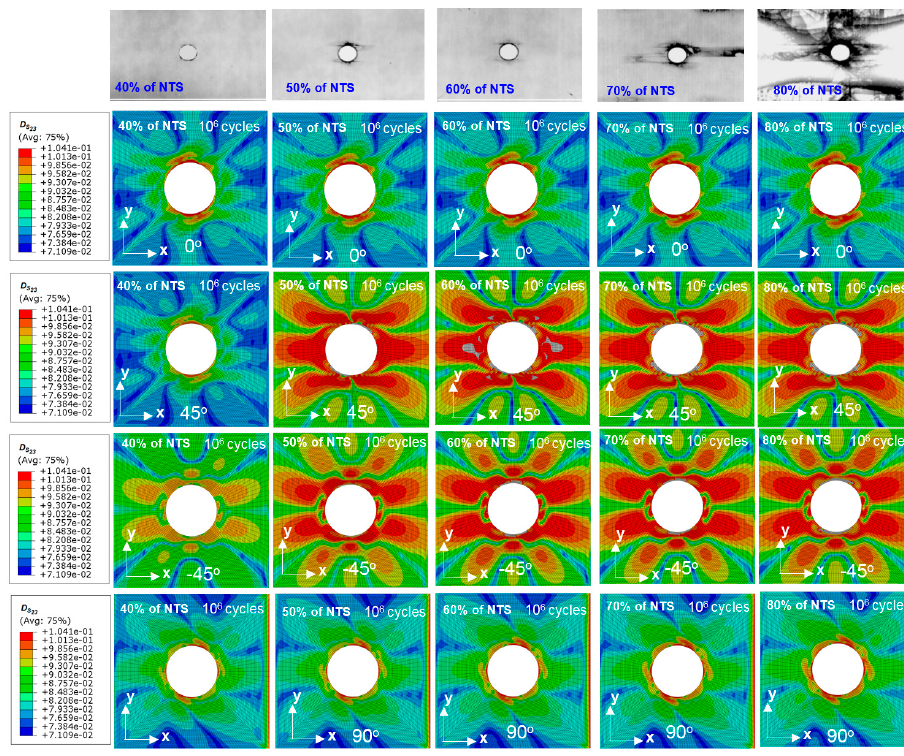
Figure 18. Reduction in strength S 23 in each ply of the OHT specimen after 10 6 cycles.